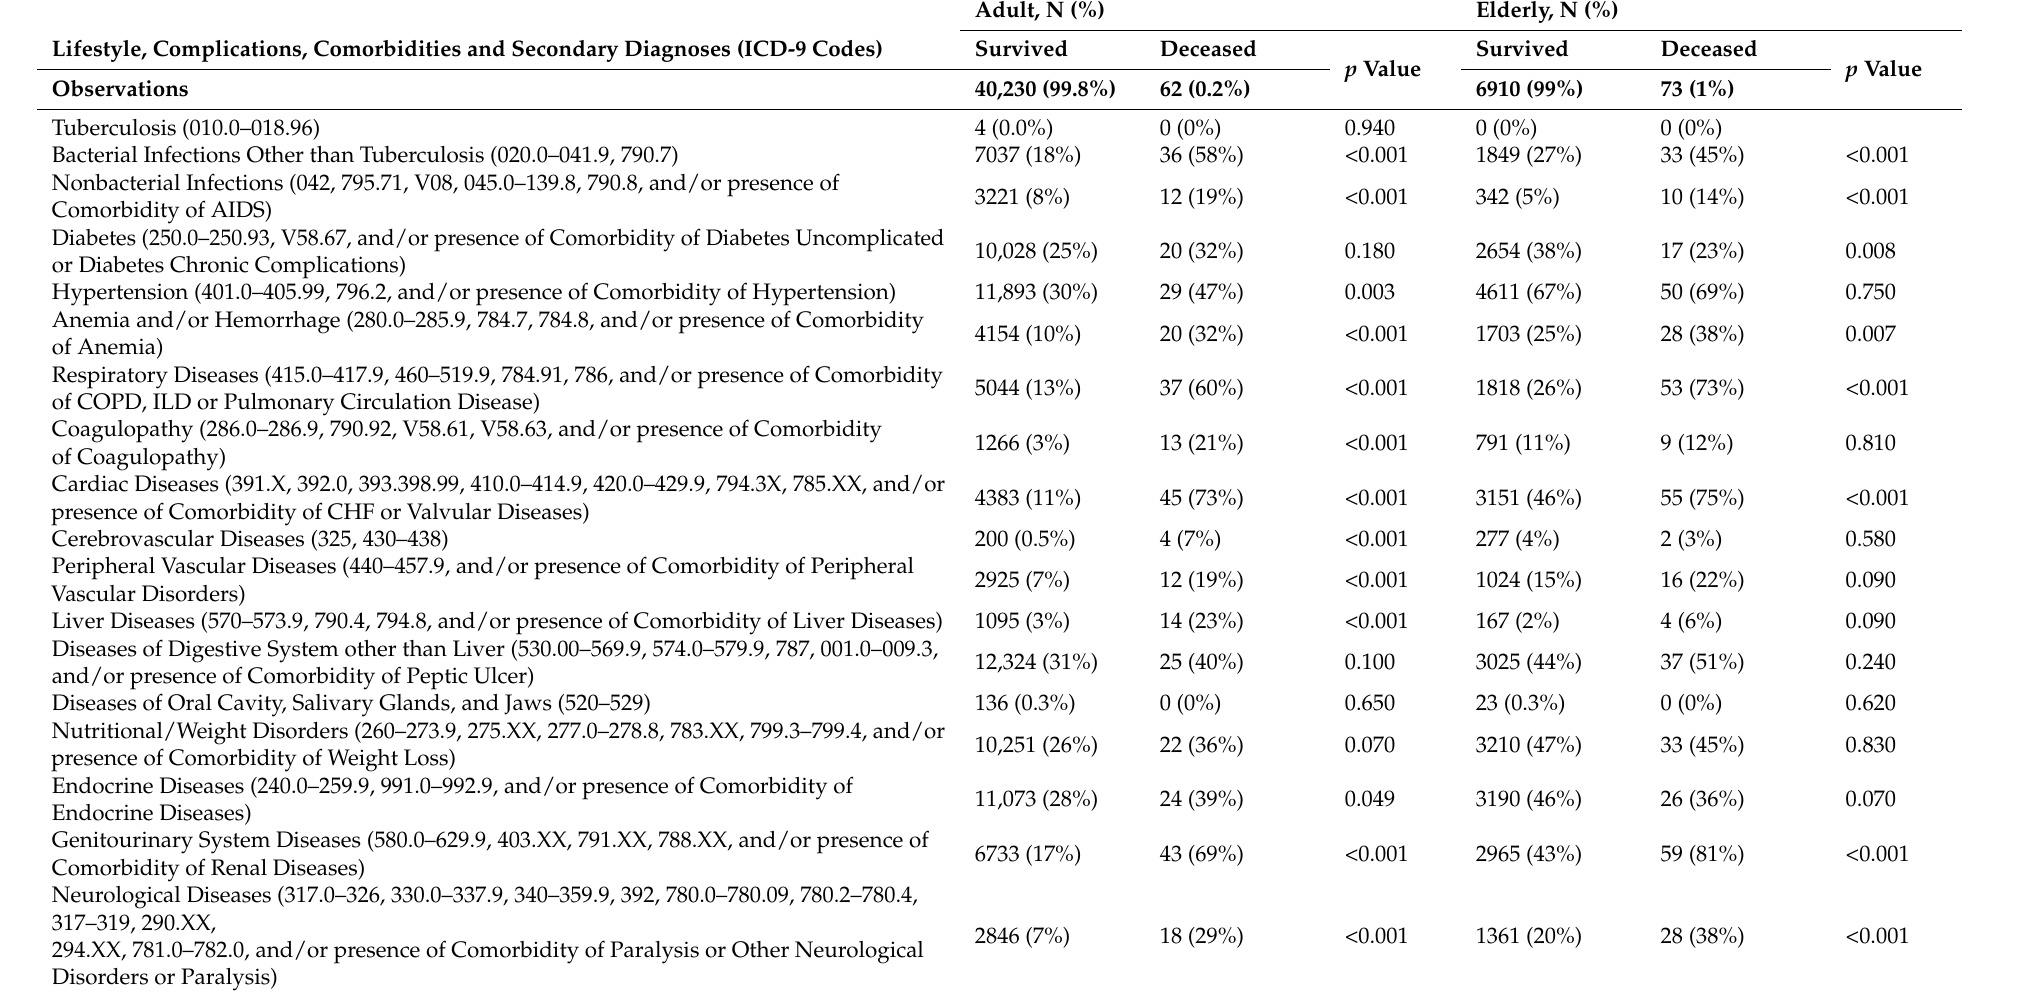
Table 5. Secondary diagnoses of patients emergently admitted with a primary diagnosis of abscess of anal and rectal regions (NIS 2004–2014). Data are stratified according to survival